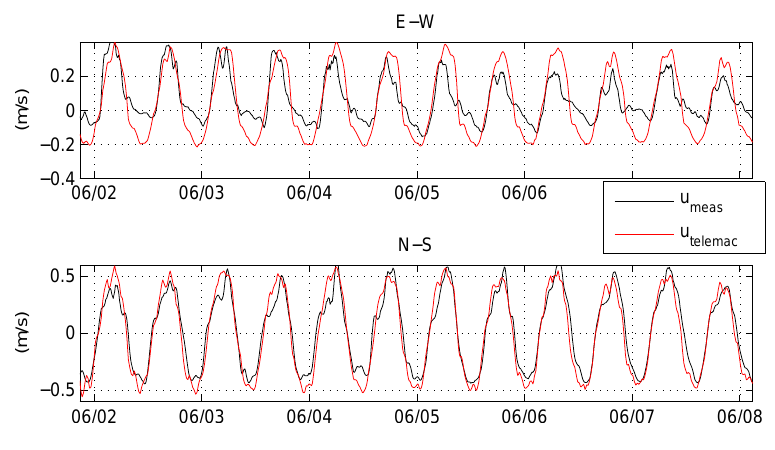
Figure 9. Comparison of the E-W and the N-S velocity components between simulated velocity and measured velocity.